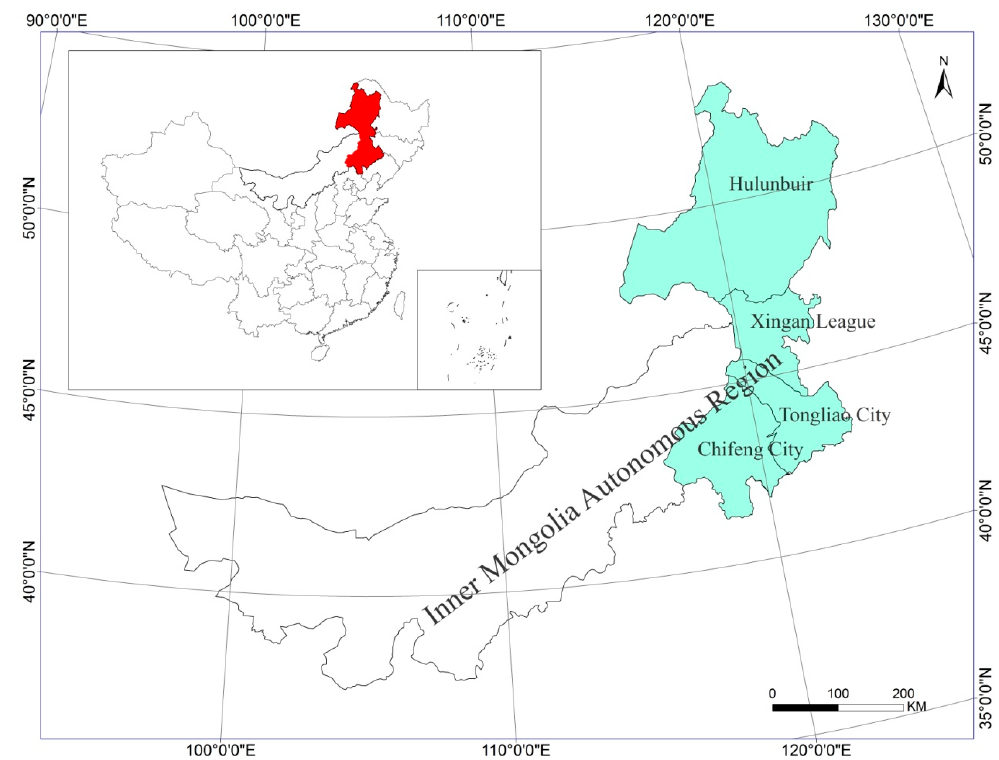
Figure 1. The location of the study area in the Inner Mongolia Autonomous Region, Northeast China.